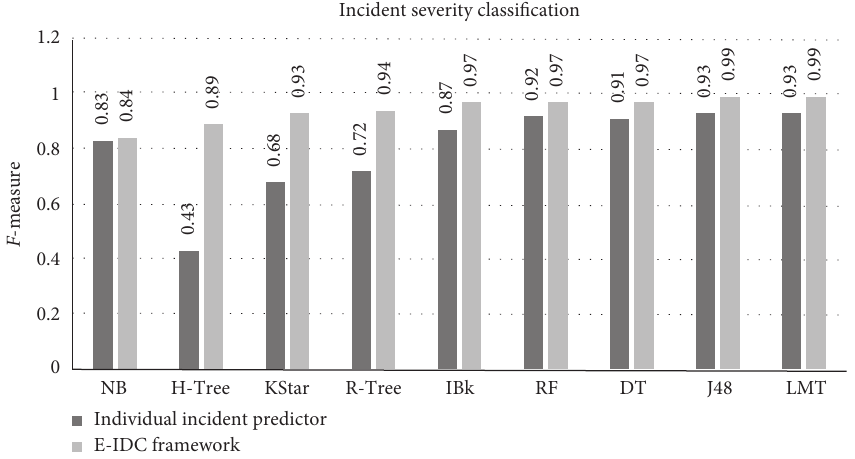
Figure 6: F-measures of individual and ensemble E-IDC